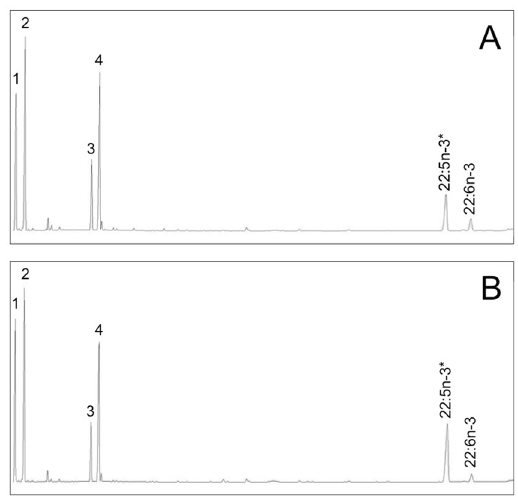
Figure 4. Δ 4 desaturase activity towards 22:5n − 3 of the newly cloned fads2 from Oryzias latipes ( A ) and Oreochromis niloticus ( B ). Peaks 1–4 represent Saccharomyces cerevisiae endogenous FA, namely 16:0 (1), 16:1 isomers (2), 18:0 (3) and 18:1n-9 (4). Peaks derived from exogenously added substrates ( * ) and the desaturation product 22:6n − 3 (DHA) are indicated accordingly.